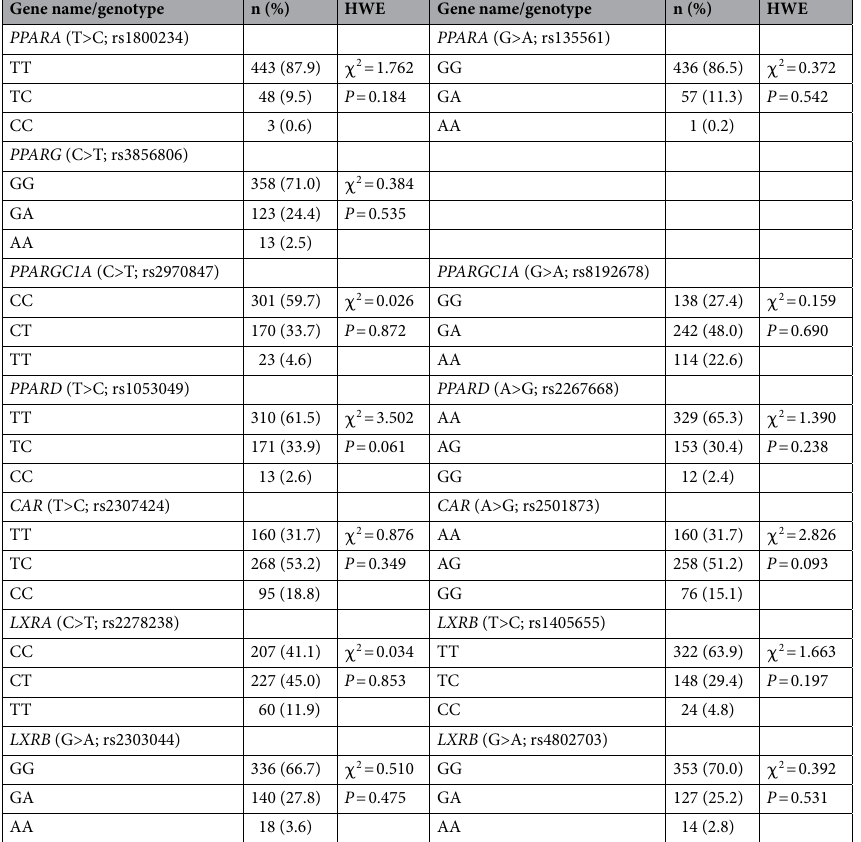
of prostaglandin-endoperoxide synthase 2 44 and increases prostaglandins 43 . Thereafter, ligand binding of pros- taglandins activates PPARG and PPARD , as previously reported 37–40,42 . PPARD activation upregulations the enzymes directly responsible for FA synthesis, including acetyl-CoA carboxylase β (ACCβ), fatty acid synthase (FAS), acyl-CoA thioesterase 1, and ATP citrate lyase; enzymes for elongation and modification of fatty acids including ELOVL family member 6 (ELOVL6), stearoyl-CoA desaturase 2 (SCD2), and glycerol-3-phosphate acyltransferase (GPAT); and malic enzyme in the pyruvate/malate cycle and phosphogluconate dehydrogenase (PGD) in the pentose phosphate pathway to provide reducing power for lipid synthesis 45 . The PPARD rs1053049 (T>C; 3 ′ -untranslated region of exon 9) TT genotype demonstrated reduced PPARD gene expression levels 41 , higher levels of low-density lipoprotein cholesterol and increased risk of type 2 diabetes mellitus 47 , increased insulin sensitivity and decreased body mass with sports training or lifestyle intervention 26,48,49 . The PPARD dynamic balance performance 51 , higher habitual physical activity 52 , and higher peak aerobic capacity on a tread- mill (VO 2 peak ) 48 . PPARD activation induces decreased TG levels coupled with up-regulation of genes related to lipid droplet secretion 52 . Therefore, PPARD (rs1053049 and rs2267668) genotypes might modify the association between PFOS levels and each FA level during pregnancy. We speculated that PPARGC1A (rs8192678) GG genotype (compared to GA/AA genotype) increased both PPARGC1A and PPARG gene expression levels due to PFOS-induced ligand-binding of prostaglandins 37–40,42–44,54 ; increased PPARG activation increased TG or FA levels via decreasing FA synthesis in the liver 45 ; finally, increased PFOS exposure relatively decreased TG or FA levels 14 . PPARGC1A is one of the co-activators of PPARG , which interacts with PPARG . In previous studies, PPARG activation increased enzymes directly responsible for fatty acid synthesis including acyl-CoA synthase (ACS), fatty acid-binding protein 2 (aP2), and acyl-CoA–binding pro- tein (ACBP) 55 . The PPARGC1A rs8192678 (G>A, Gly482Ser; exon 8) GG genotype demonstrated higher sports performance, athletic ability 56 , endurance performance ability 57 , hepatic adenosine triphosphate (ATP) levels 58 , PPARGC1A gene expression 54 , lower risk of polycystic ovarian syndrome 59 , nonalcoholic fatty acid disease 30 ,